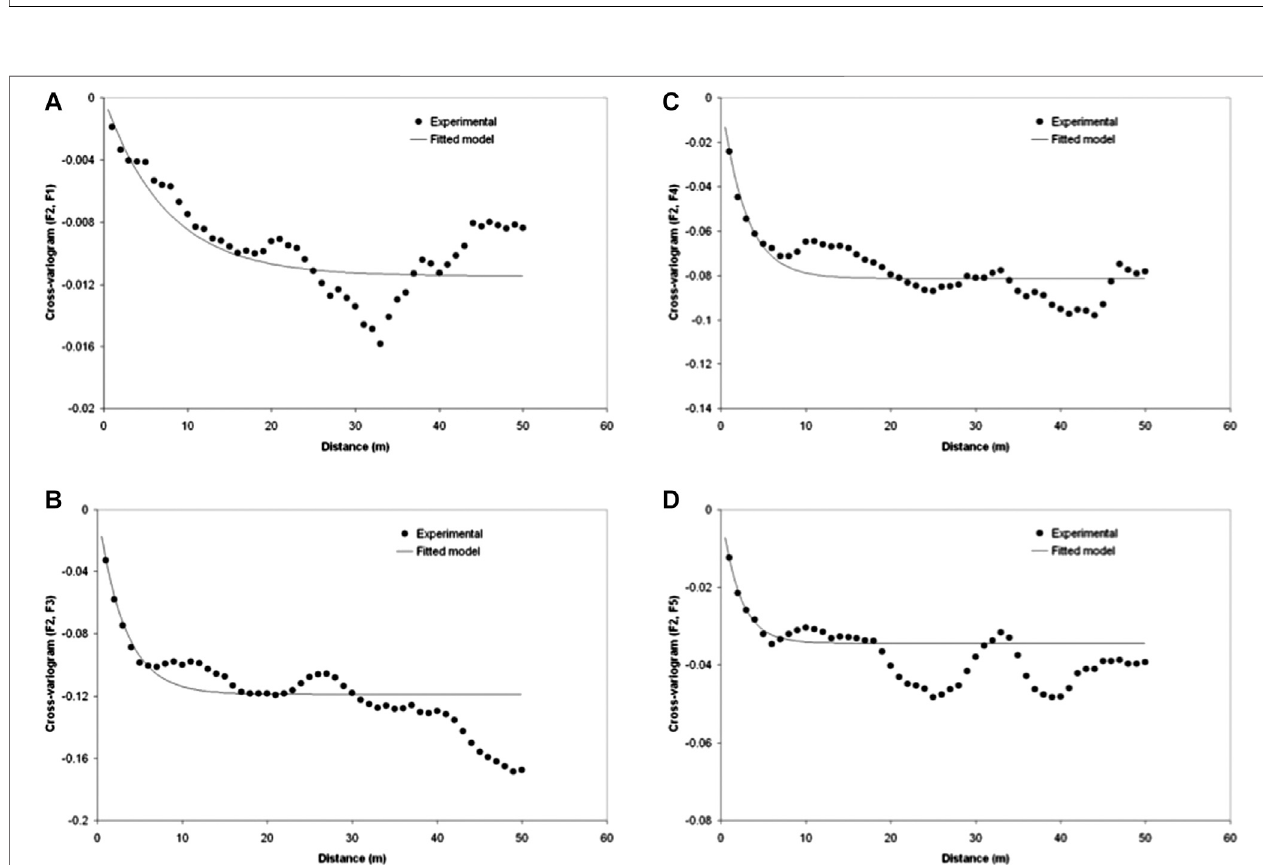
FIGURE 6 | Indicator cross-variograms between hydrofacies F2 and the other hydrofacies and models fi tted to them: (A) F2-F1; (B) F2-F3; (C) F2-F4 and (D) F2-F5.